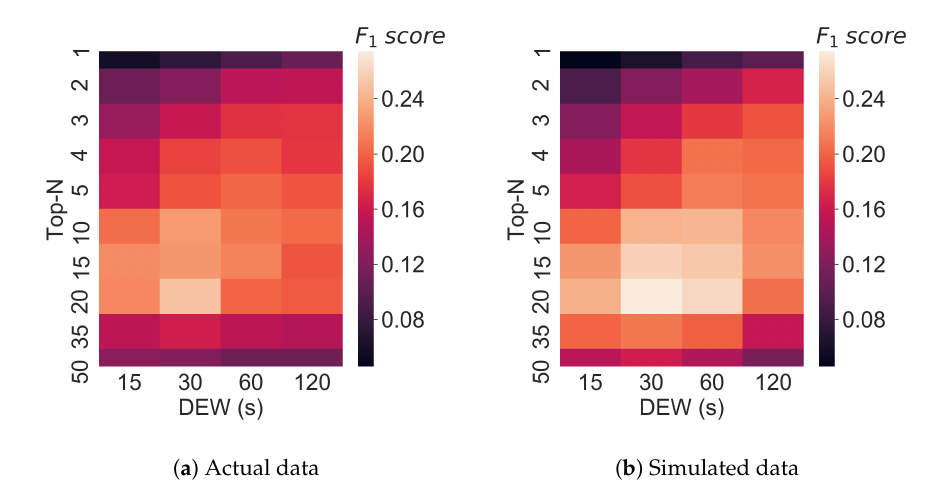
Figure 6. Fragmentation performance in terms of F 1 score for ( a ) an actual BeerQCB sample, ( b ) simulated results from ViMMS.